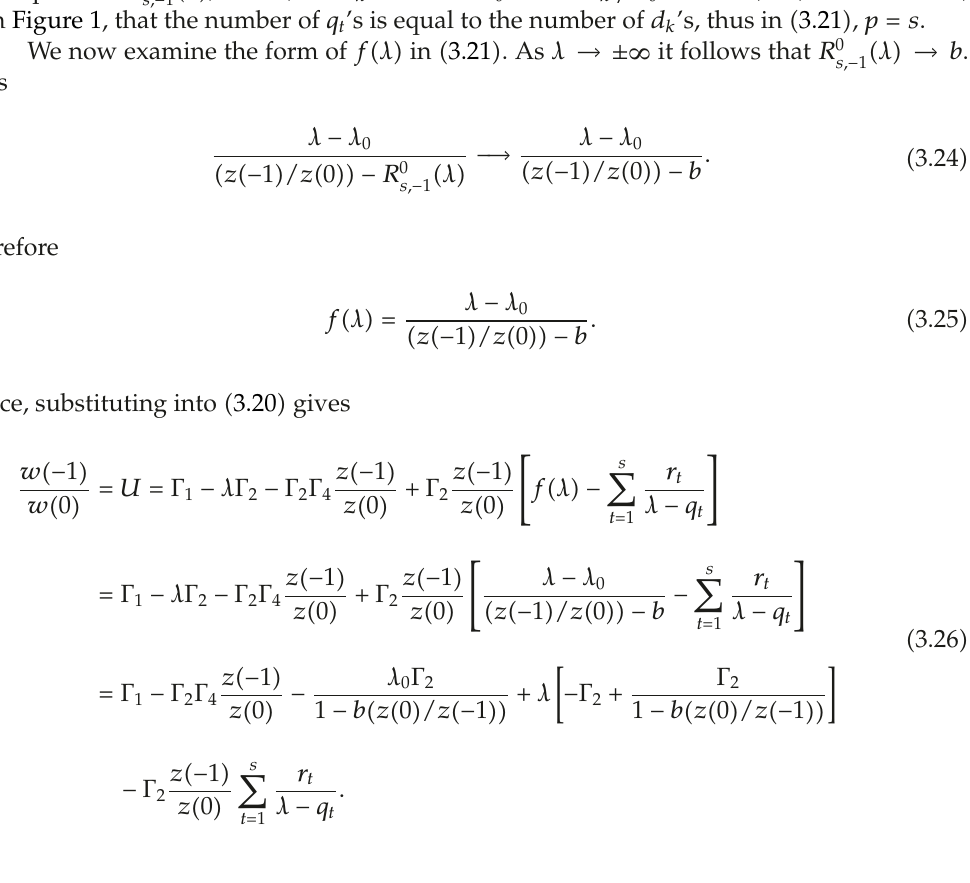
(cid:2) λ (cid:3) s, − 1